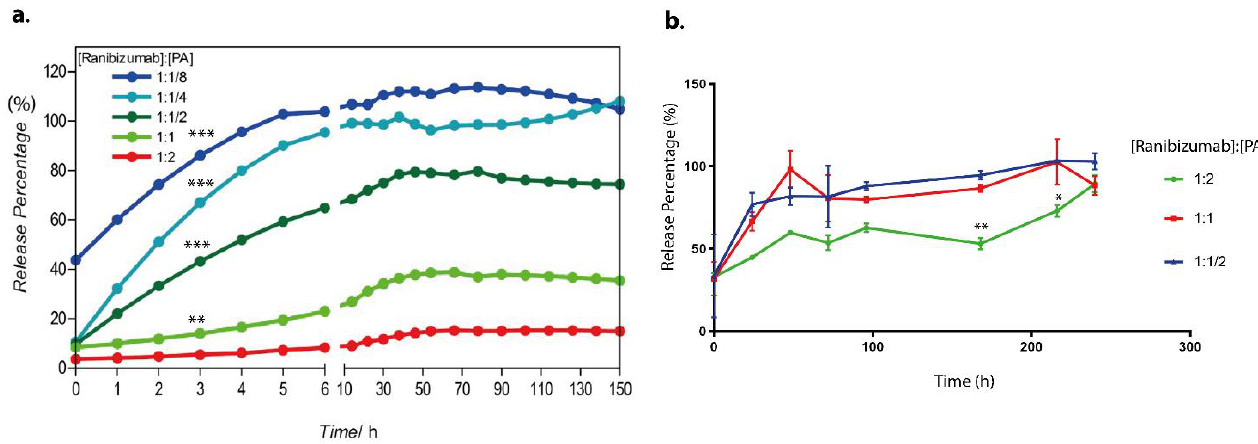
Figure 2. The cumulative release profile of the anti-VEGF ranibizumab from the peptide nanofiber gels with different [ranibizumab]:[PA] ratios ( a ) into water (from 1:1/8 to 1:8) and ( b ) into vitrein (from 1:1/2 to 1:2). Values represent mean ± SEM, n = 3 (*** p < 0.0001, ** p < 0.01, * p < 0.05).